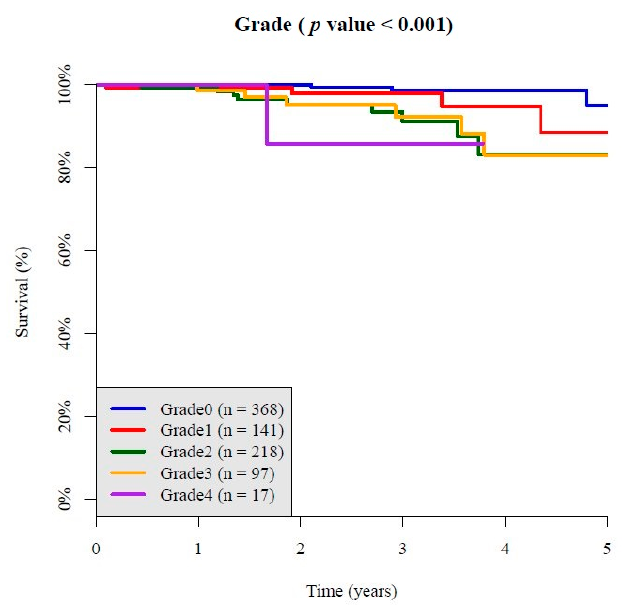
Figure 3. The Kaplan–Meier survival curve showed a stepwise fashion of CKD incidence from mild NPDR to moderate NPDR, to severe NPDR, to